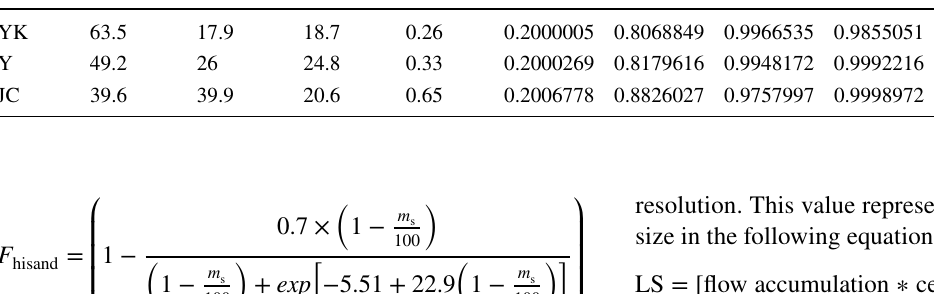
Table 2 Method to calculate K Soil sample